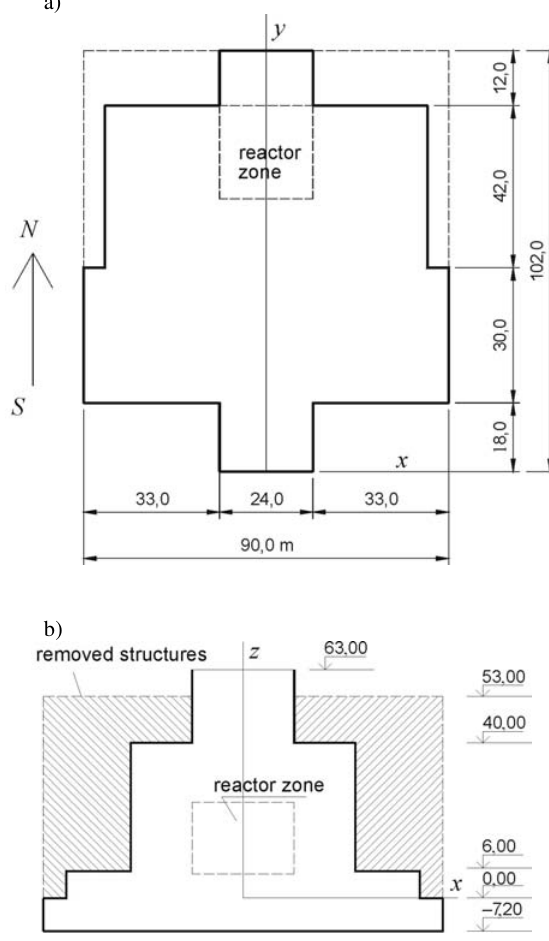
Fig. 2. Schematic illustration of the building: a – layout of the building; b – outline of the monolithic and removed prefabricated structures